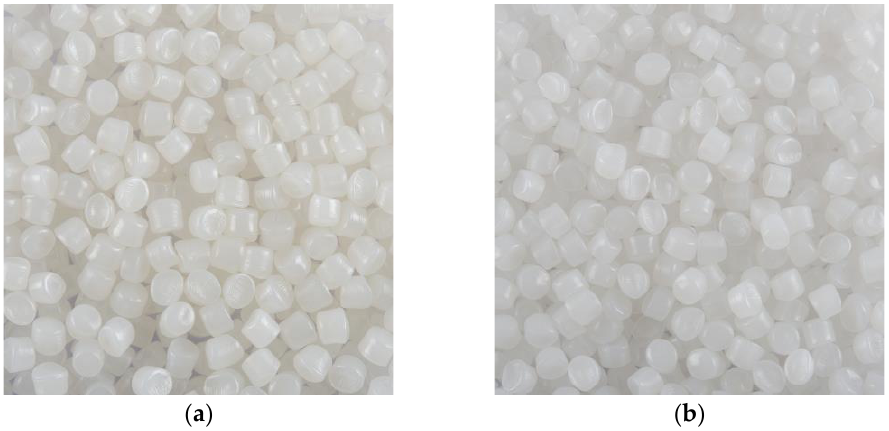
Figure 1. Images of the pellets of the virgin blow molding PE-HD grades vPE-1 ( a ) and vPE-2 ( b ). Considering the two basic constraints, color and MFR, two rPE-HD grades were pur- chased from two different European suppliers based on their white (rPE-A) and natural (rPE-B) colors and MFRs, which are in the range of the benchmark virgin grades. The recyclates were delivered as pellets, as can be seen in Figure 2. rPE-A is an opaque white color while rPE-B has a more translucent tone or rather natural color. ( a ) ( b ) Figure 2. Images of the pellets of the PE-HD recyclates rPE-A in opaque white ( a ) and rPE-B in natural ( b ). 3. Methods Differences in specimen preparation, conditioning, and testing often impede objec- tive comparisons between material data of different suppliers. Moreover, small lot-to-lot variations can occur even for virgin grades. Therefore, within the scope of this study, all basic properties were characterized by identical parameters for better comparability and accurate structure – property – performance relationships. 3.1. Melt Mass-Flow Rate Measurements The MFR measurements were conducted at 190 °C and with both 2.16 kg and 5 kg static loads on the melt flow indexer Mflow (ZwickRoell GmbH & Co. KG, Ulm, Germany) according to ISO 1133-1 [11] and ISO 17855-2 [27]. Cuts were automatically made after every 1 mm (2.16 kg) and 3 mm (5 kg) piston movement. The time between cuts was meas- ured and each extrudate was weighed on an ABS 220-4 electronic balance (Kern & Sohn GmbH, Balingen-Frommern, Germany). The MFR in g/10 min was calculated by